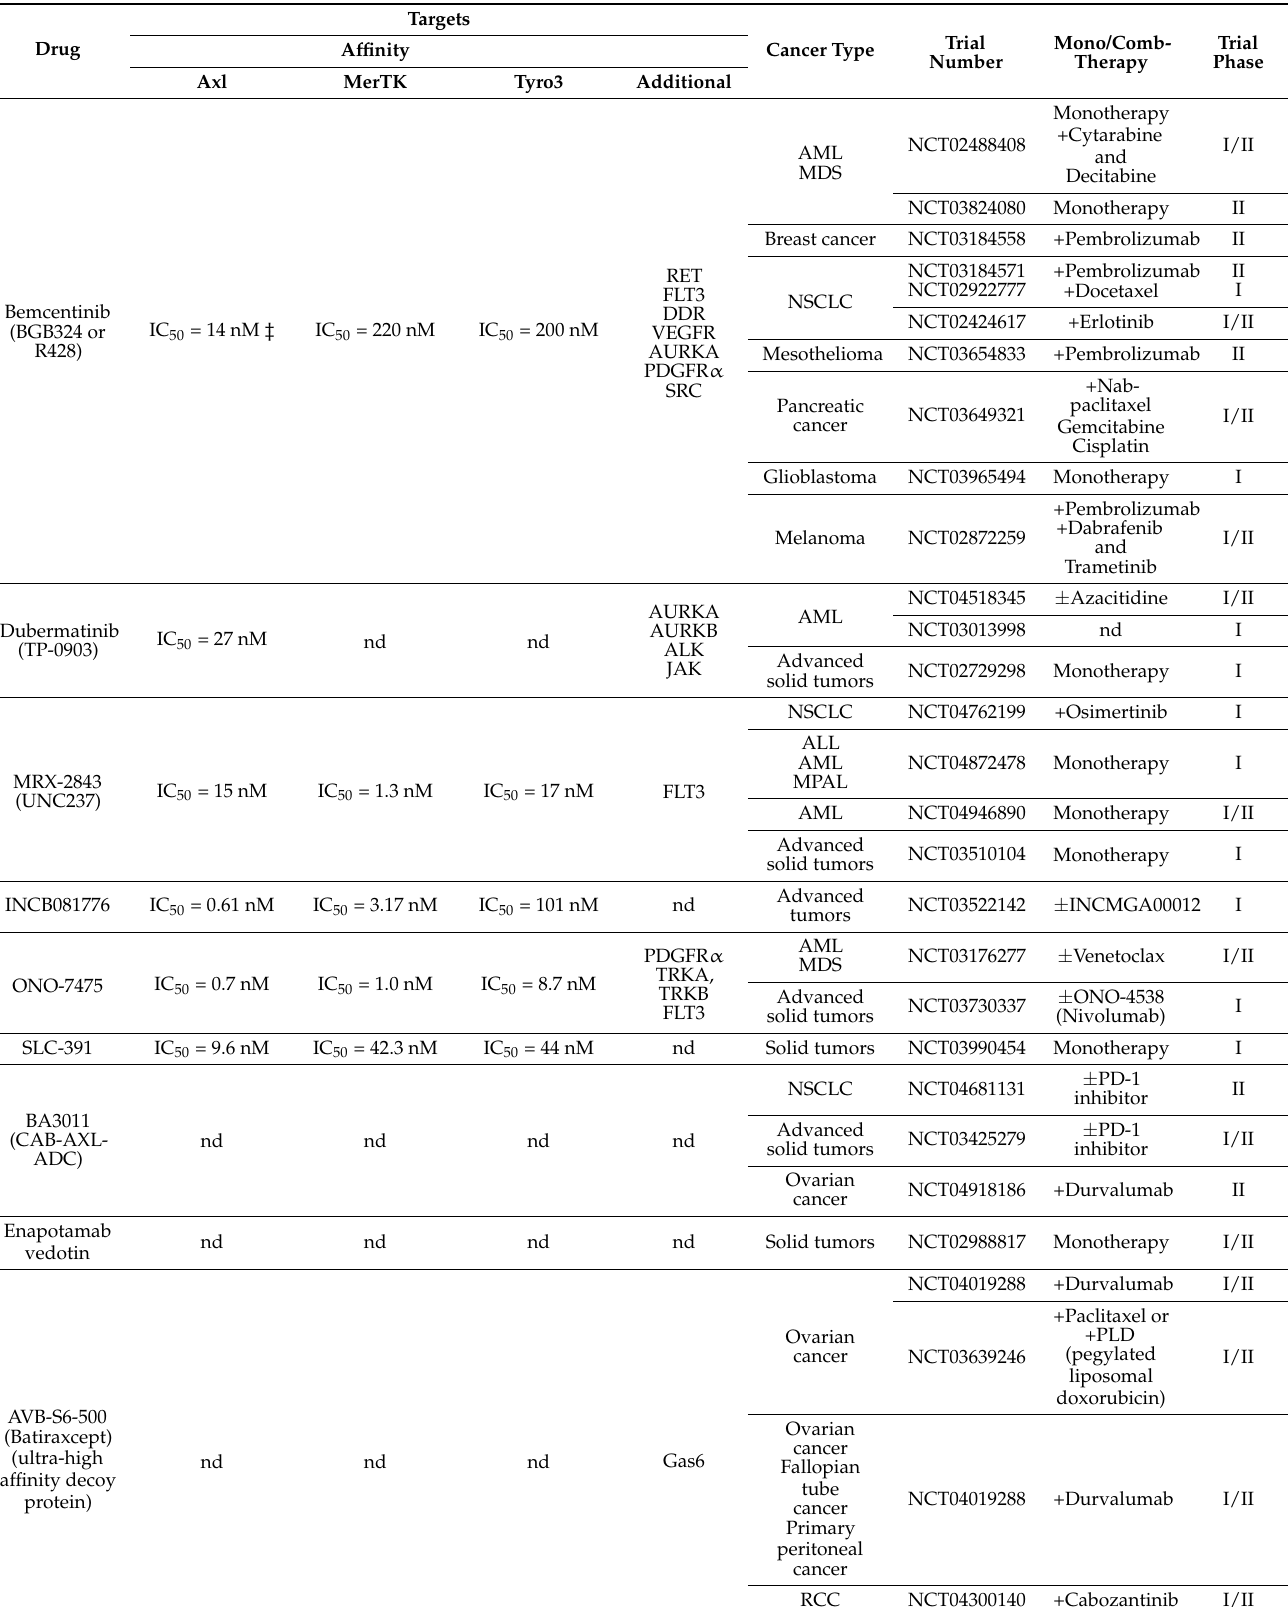
Table 1. TAM-selective